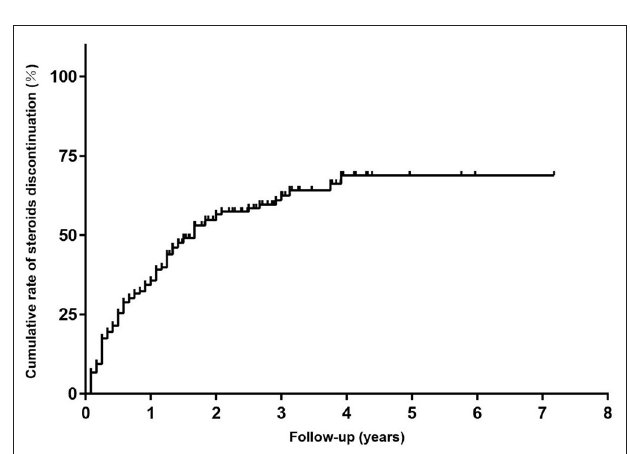
FIGURE 4 | The Kaplan-Meier curve for time to discontinued steroids in children with steroid-resistant